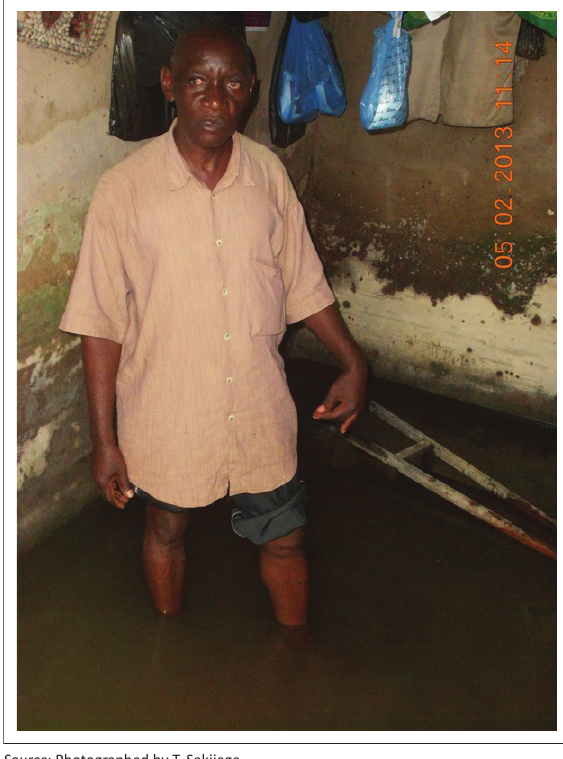
FIGURE 6: Dampness and waterlogging inside a house in Keko Machungwa resulting from underground water percolation.